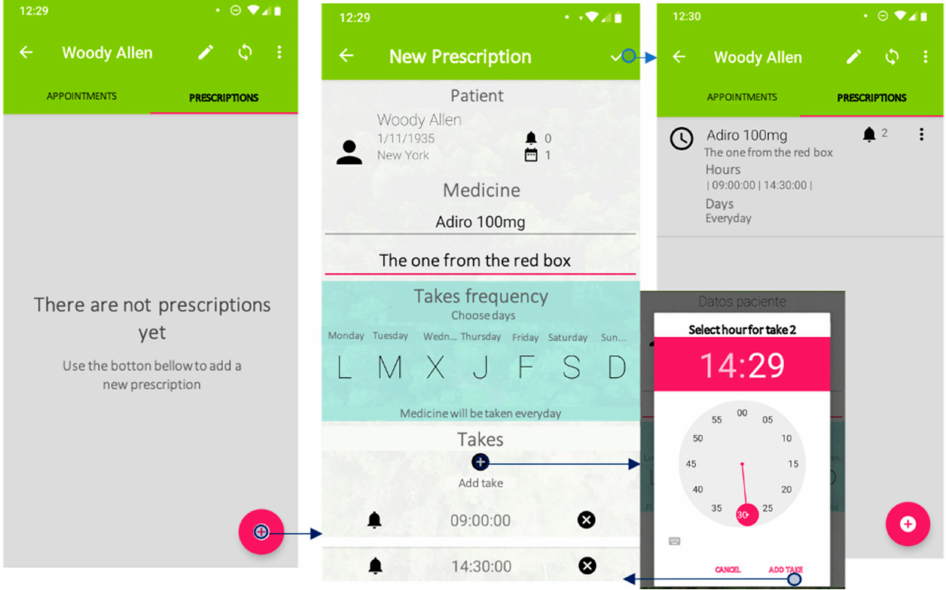
Figure 4. Adding a new prescription with the mobile application.